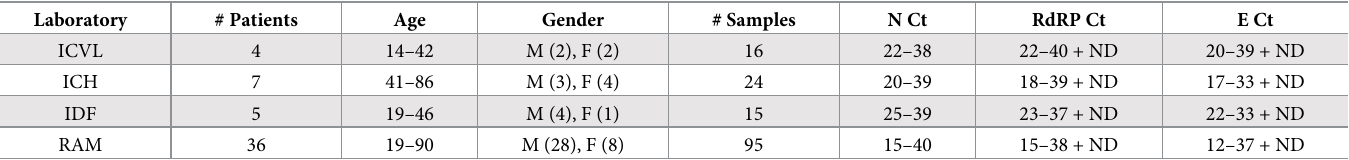
Table 1. Summary of the samples (n = 150) included in this study.